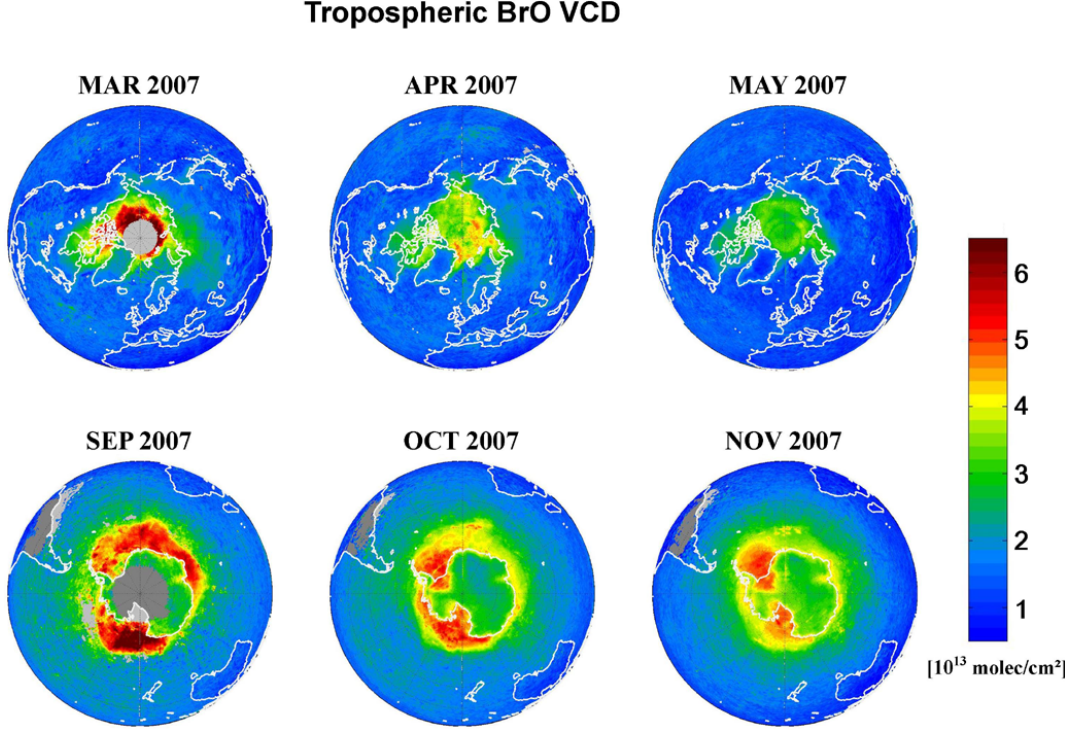
Fig. 8. Monthly averages of GOME-2 tropospheric BrO vertical columns in polar spring 2007 for the Northern Hemisphere (upper plots) and the Southern Hemisphere (lower plots). Only data corresponding to solar zenith angles lower than 80 ◦ are